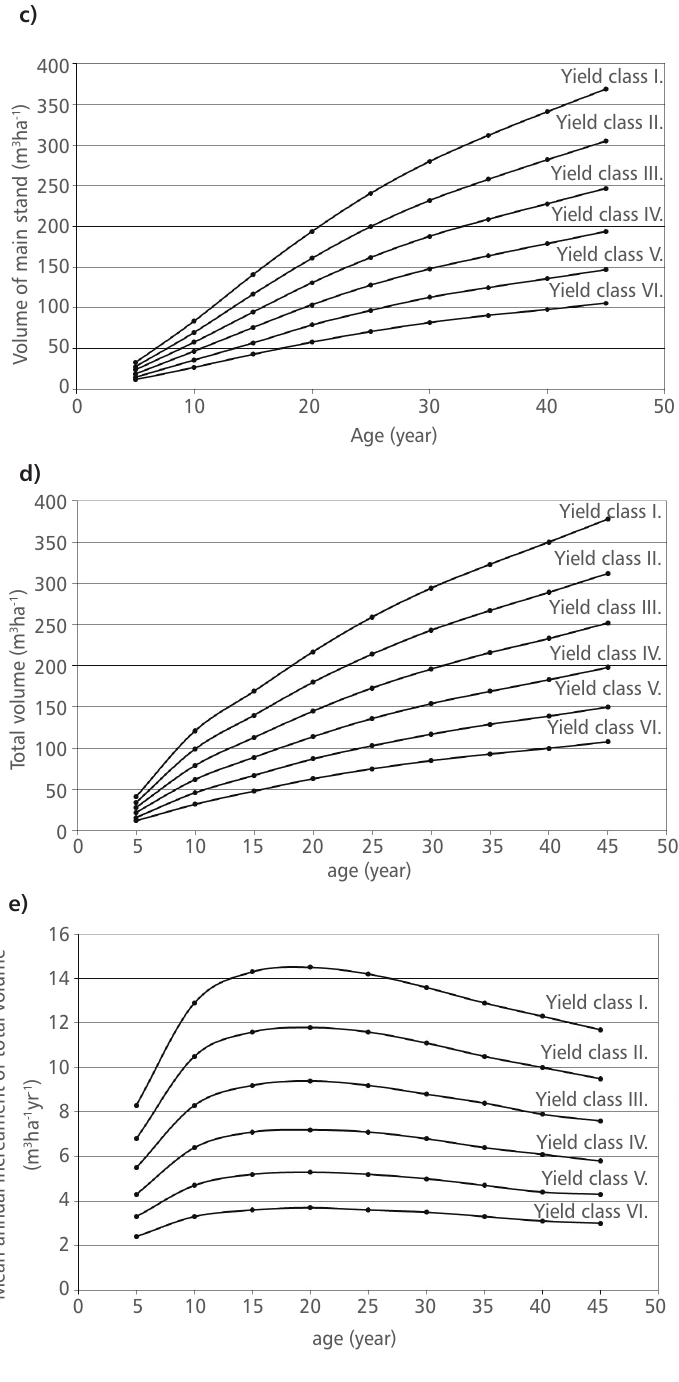
FIGURe 3. a-e. Data of stand structure and yield of black locust ( Robinia pseudoacacia L.) stands as a function of the age -